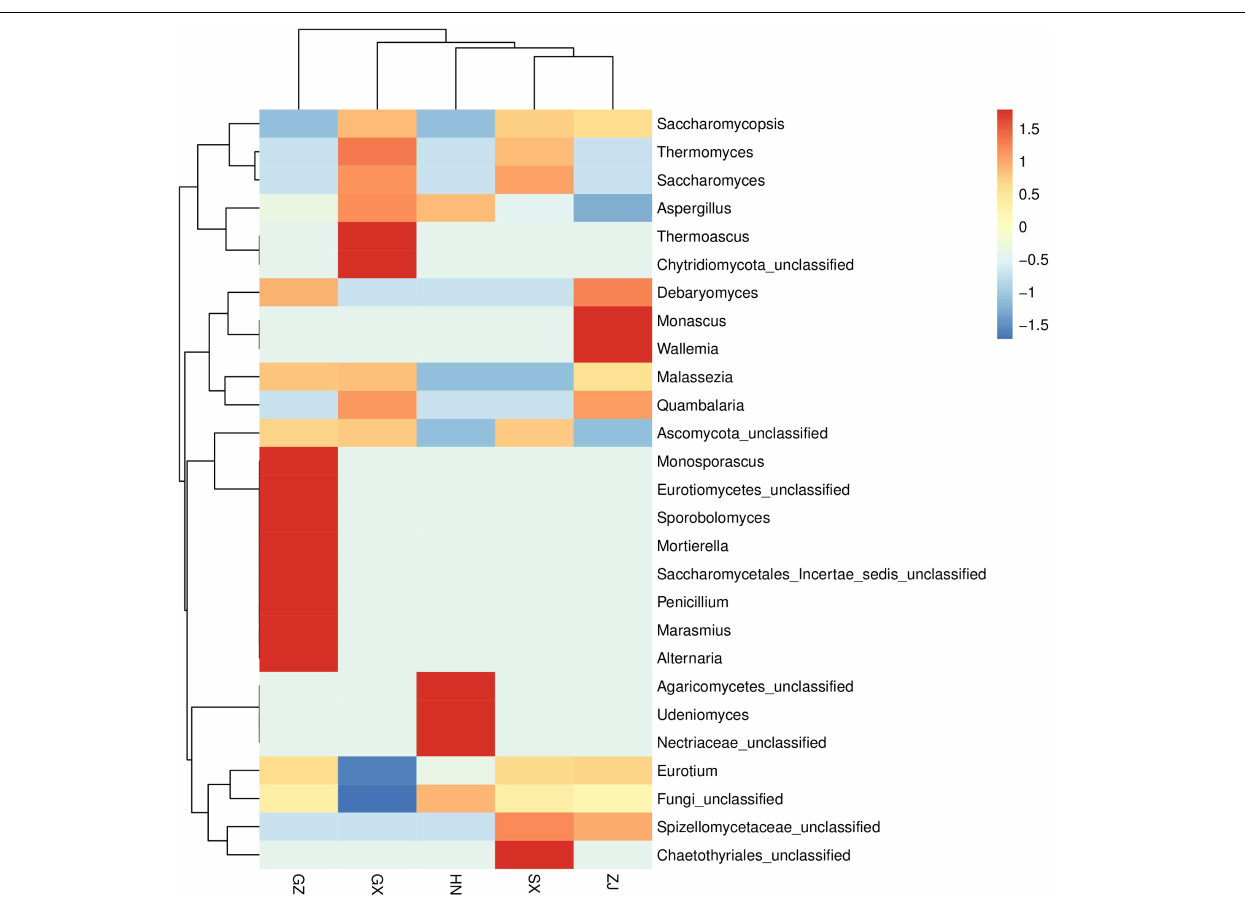
FIGURE 3 | Cluster analysis on fungal genera in five Fu brick teas in different regions.